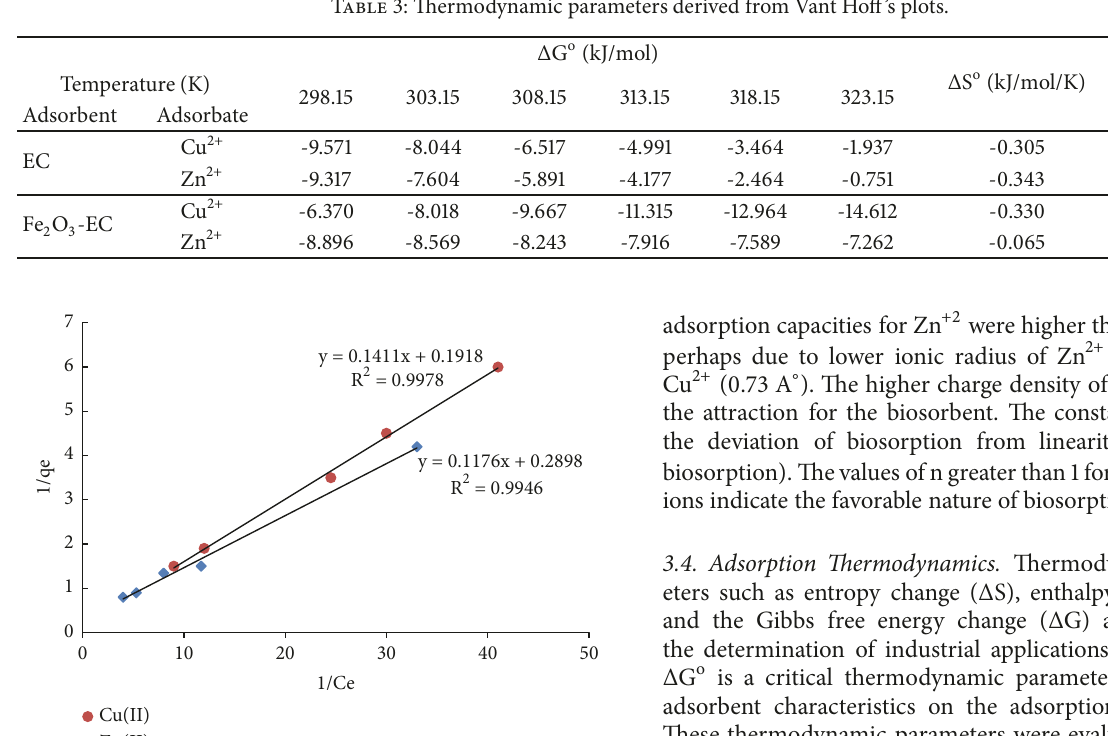
Table 3: Thermodynamic parameters derived from Vant Hoff’s plots.